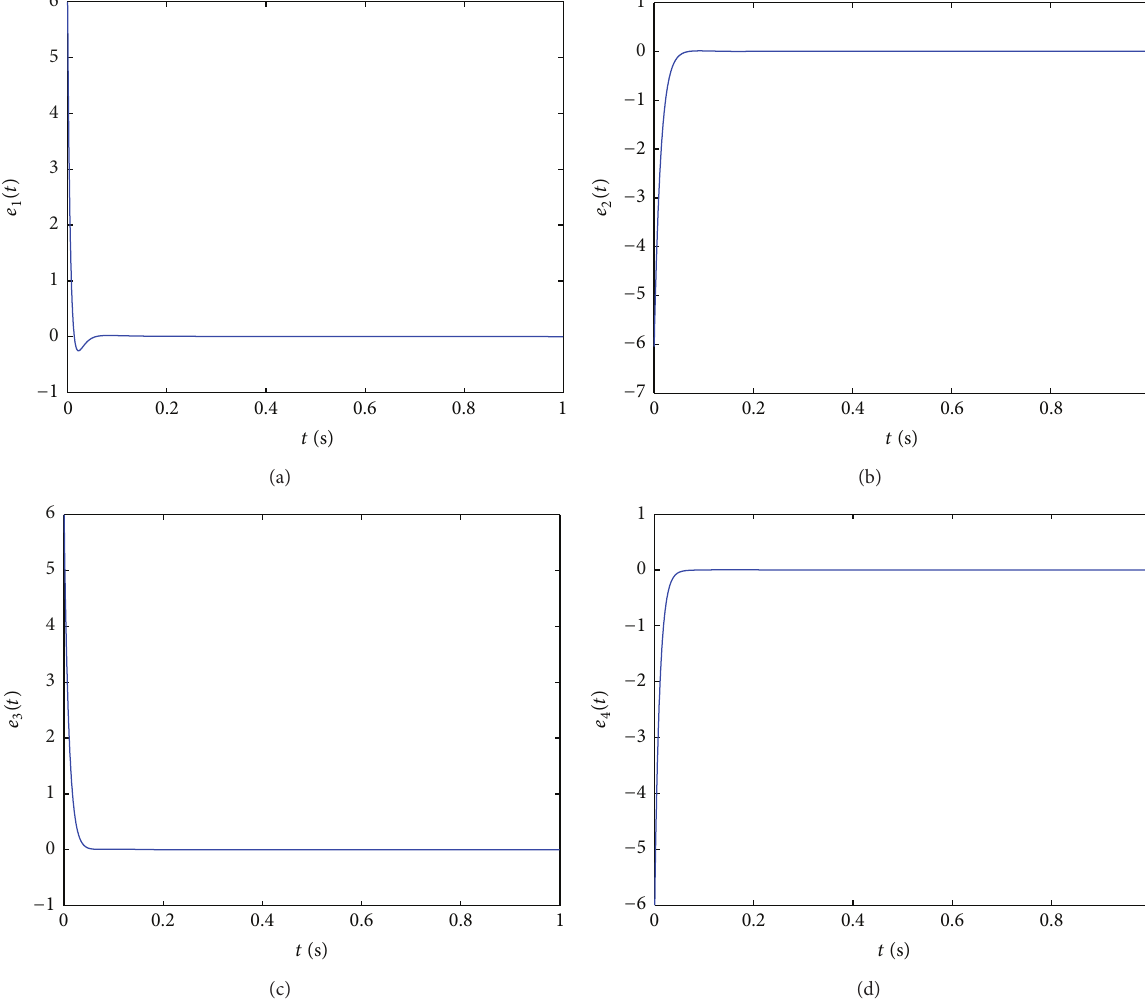
Figure 8: Time waveforms of synchronization errors 𝑒 1 (a), 𝑒 2 (b), 𝑒 3 (c), and 𝑒 4 (d) between two fractional-order hyperchaotic L¨u